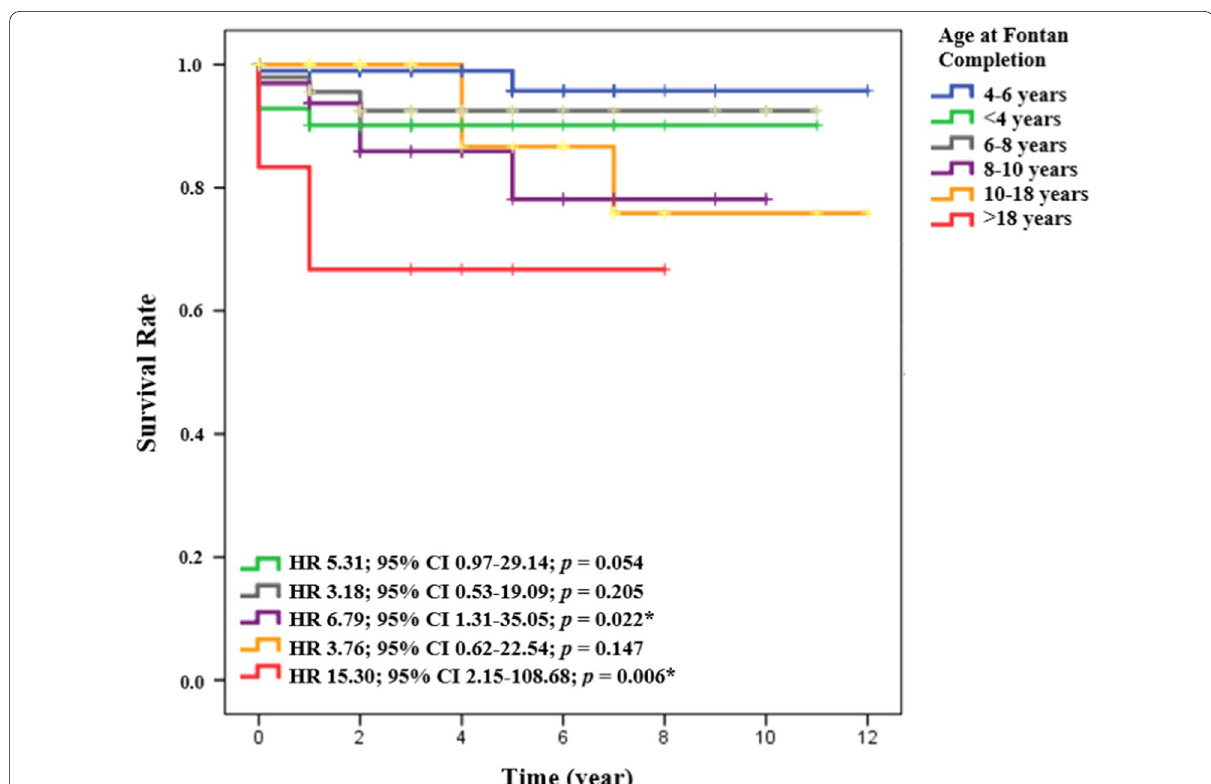
Fig. 3 Kaplan–Meier survival curve based on subgroup analysis of age at Fontan completion. HR: hazard ratio; CI: confidence interval. * p < 0.05: statistically